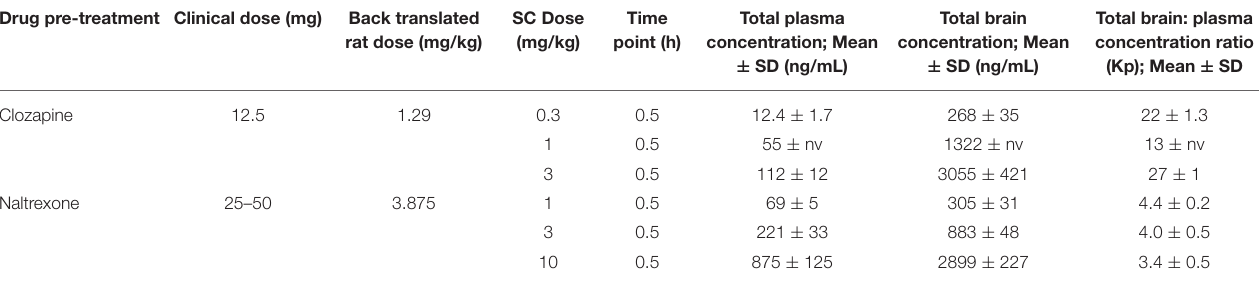
TABLE 6 | Clozapine and Naltrexone concentrations measured in terminal plasma and brain homogenate samples 1h after subcutaneous injection ( n = 3 satellite animals). Drug pre-treatment Clinical dose